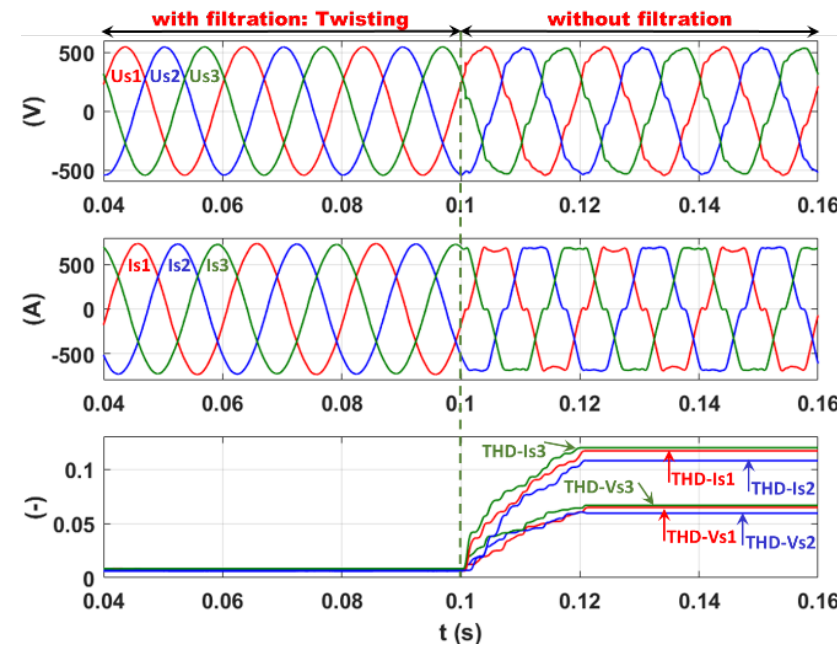
Figure 20. Current filtration: 2-SMC Twisting controller.